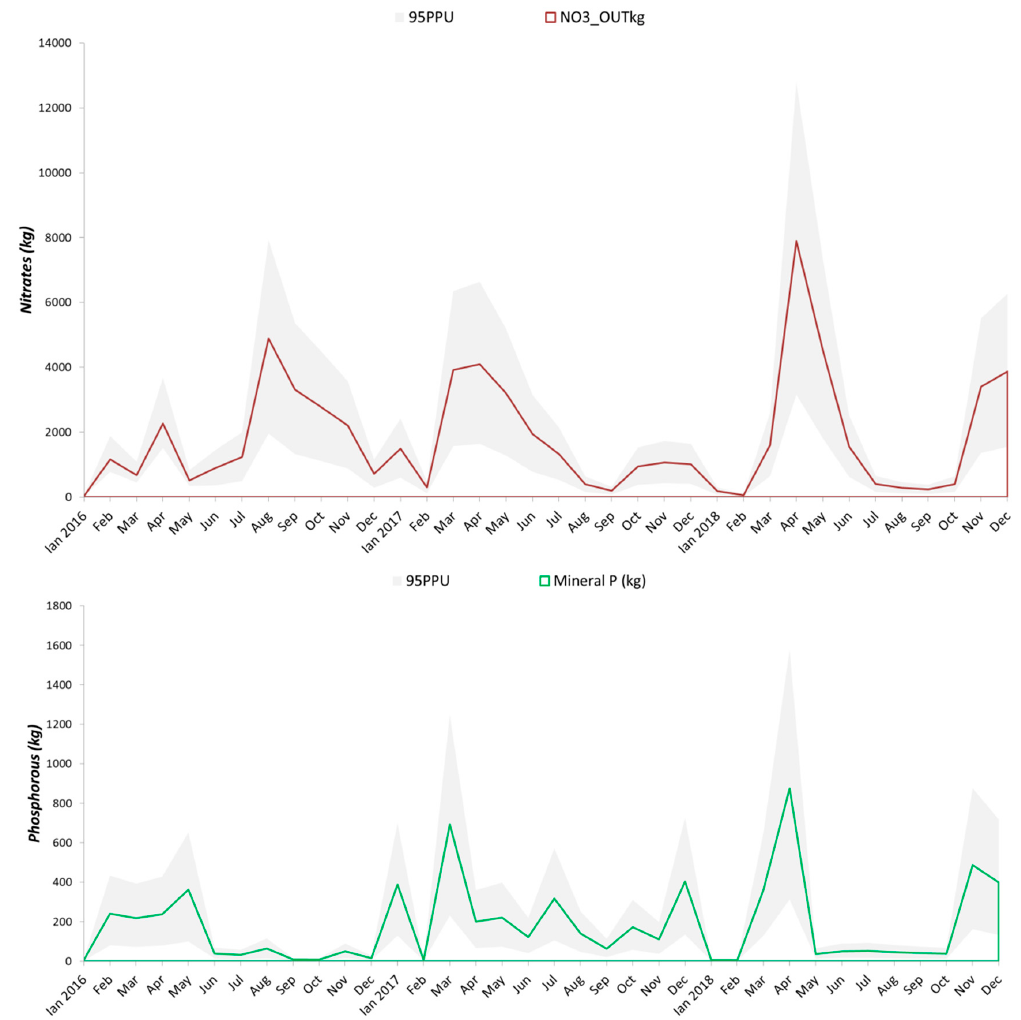
Figure 6. SWAT simulation showing the pollutant load for the reach output (TG downstream) between 2016 and 2018—river discharge, sediments (SED_OUT: Sediment transported with water out of reach in metric tons), nitrates and mineral P; sum of precipitations (mm), number of days with precipitations; 95% prediction uncertainty (95PPU).